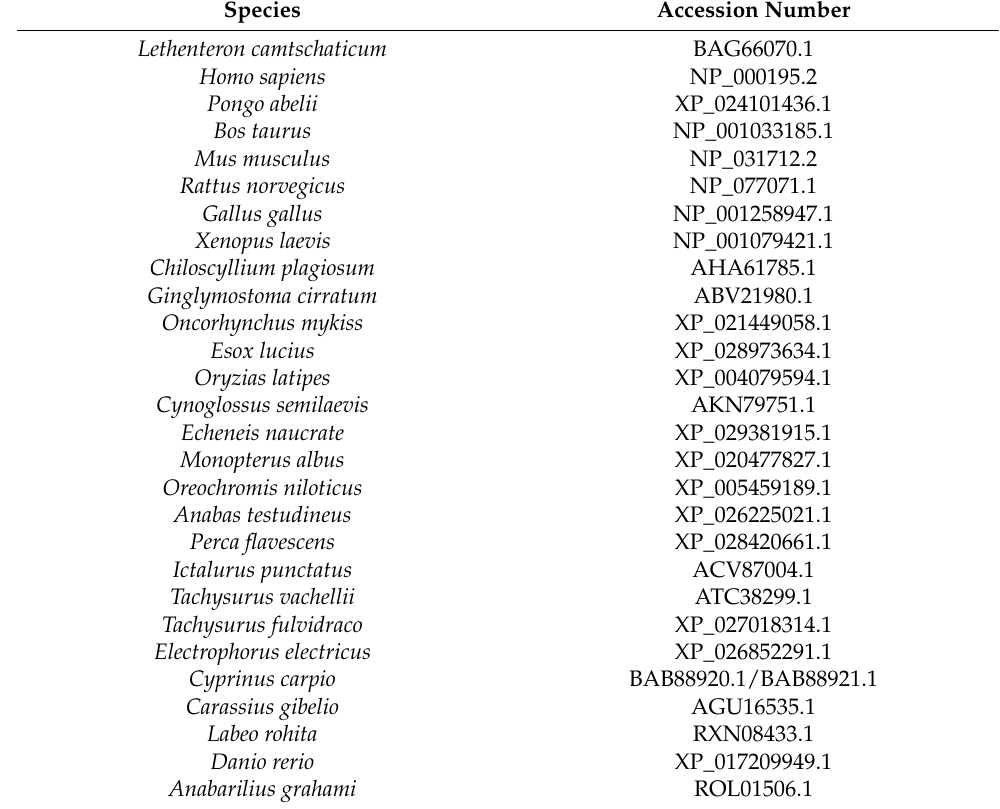
Table 1. The information of CFIs from different vertebrates used in phylogenetic analysis.